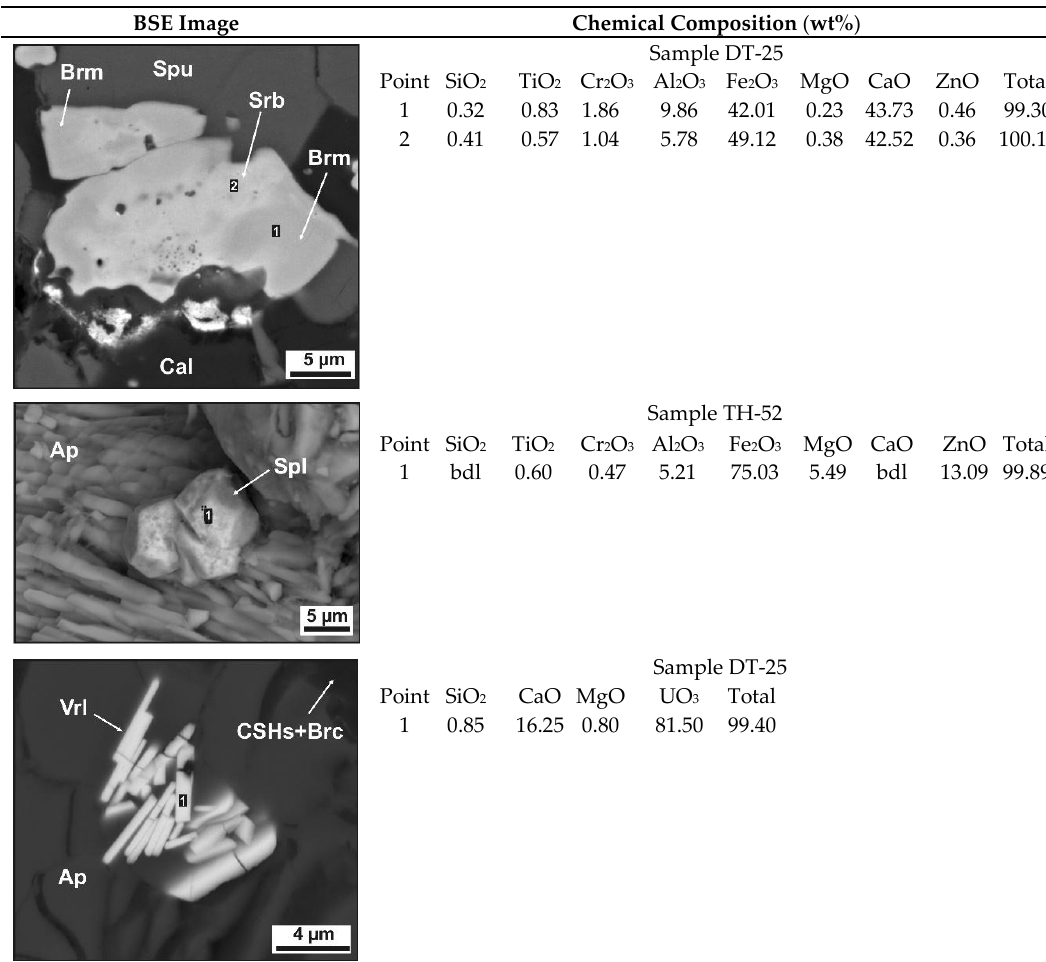
Table 8. BSE images and EDS composition (wt%) of oxide accessories associated with sphalerite in the representative CM marble samples.